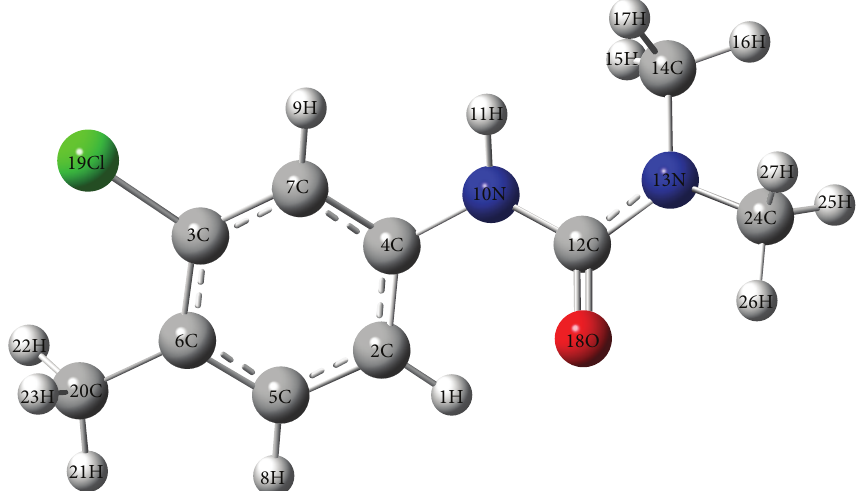
Figure 2: Optimized structure of chlorotoluron at the MP2/6-311++G(2d,2p) level of theory. Bond distances: 2C-4C = 1.40, 2C-5C = 1.39, 3C- 6C = 1.40, 3C-7C = 1.39, 4C-7C = 1.40, 5C-6C = 1.40, 6C-20C = 1.50, 3C-19Cl = 1.76, 4C-10N = 1.41, 10N-12C = 1.39, 12C-18O = 1.24, 12C-13N = 1.36, 13N-24C = 1.45, 13N-14C = 1.46, N-H = 1.00, C-H = 1.09 in methyl groups, and C-H = 1.08 in the ring. Dihedral angle 2C-4C-10N-12C = −